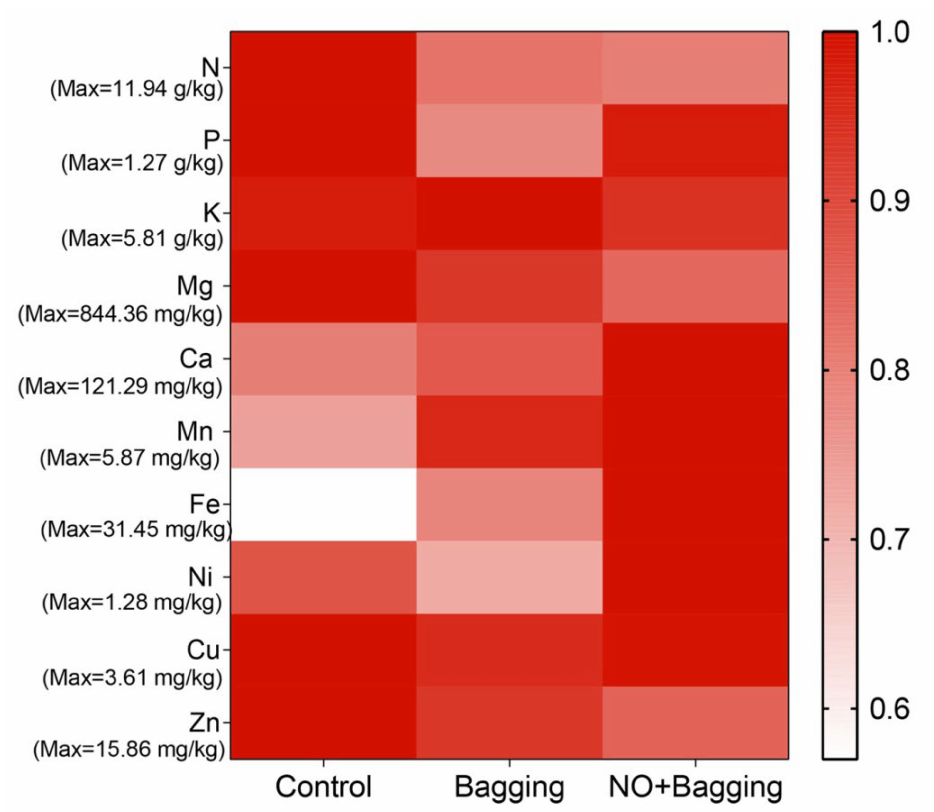
Figure 6. Heatmaps of mineral elements in blood orange fruits after different treatments. The bar represents the relative value (measured value/max value ×